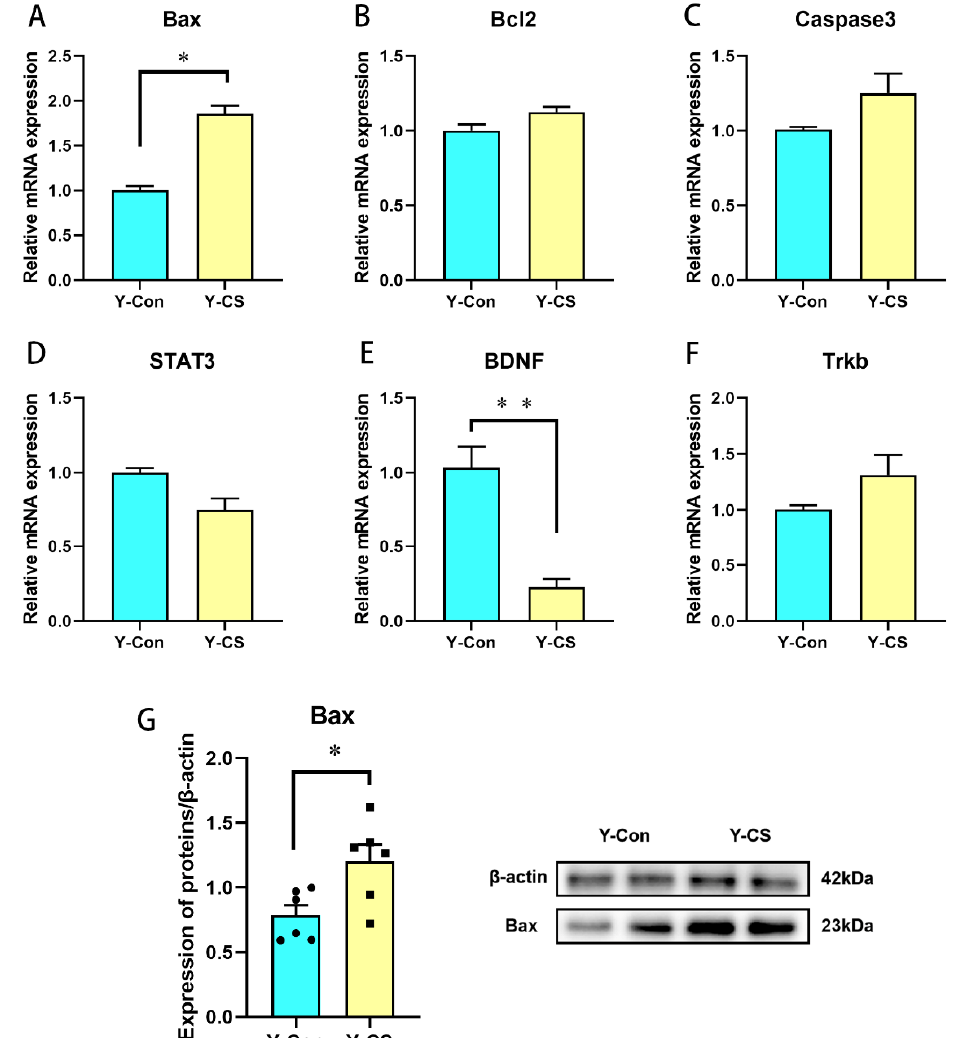
Figure 3. Chronic cold exposure promotes the apoptotic pathway and reduces the expression of brain-derived neural factor in lungs. ( A ) Bax mRNA expression. ( B ) B-cell lymphoma 2 (Bcl2) mRNA expression. ( C ) Caspase3 mRNA expression. ( D ) STAT3 mRNA expression. ( E ) BDNF mRNA expression. ( F ) Neurotrophic receptor tyrosine kinase 2 (Trkb) mRNA expression. ( G ) Bax protein expression. Data are expressed as the mean ± SEM, n = 6, * p < 0.05, ** p < 0.01.